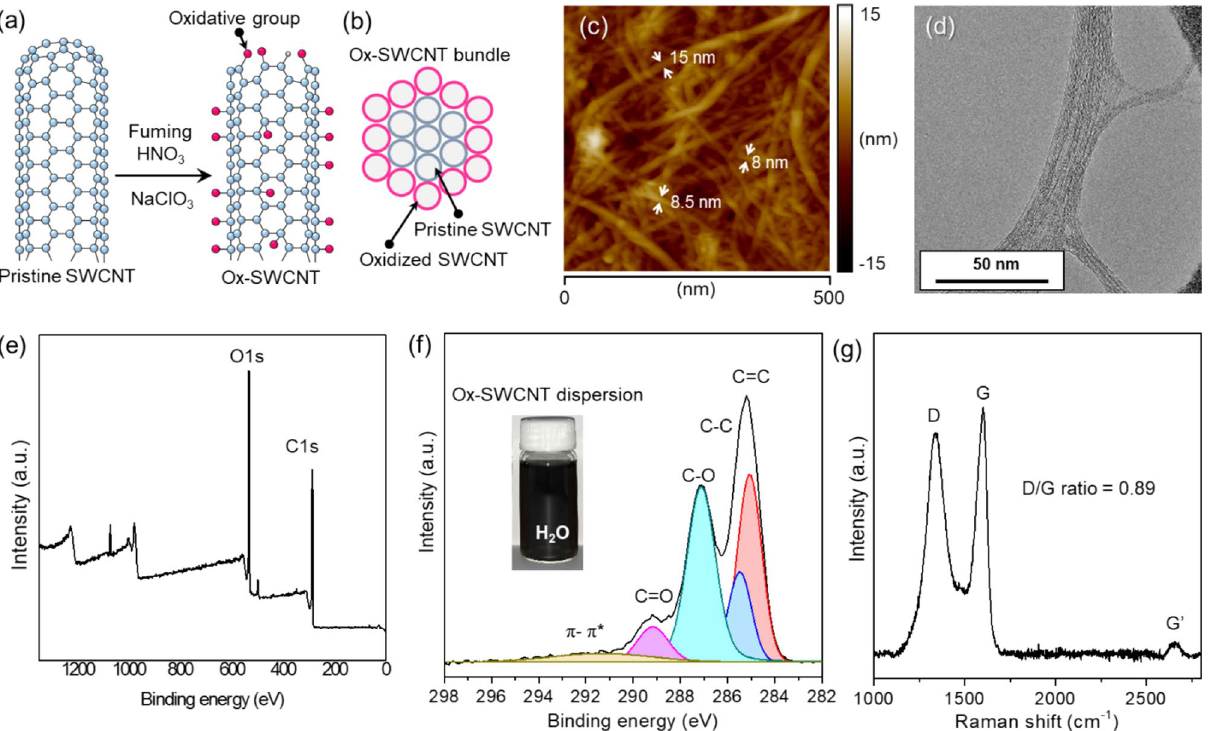
Figure 1. Illustration of ( a ) fabrication of Ox-SWCNTs with using fuming HNO 3 and NaClO 3 ( b ) the cross- sectional structure of the Ox-SWCNT bundle; core SWCNTs remain intact structures. Characteristics of Ox-SWCNTs: ( c ) AFM image, ( d ) TEM image, ( e ) survey scan plot in XPS, ( f ) C1s plot in XPS, ( g ) Raman